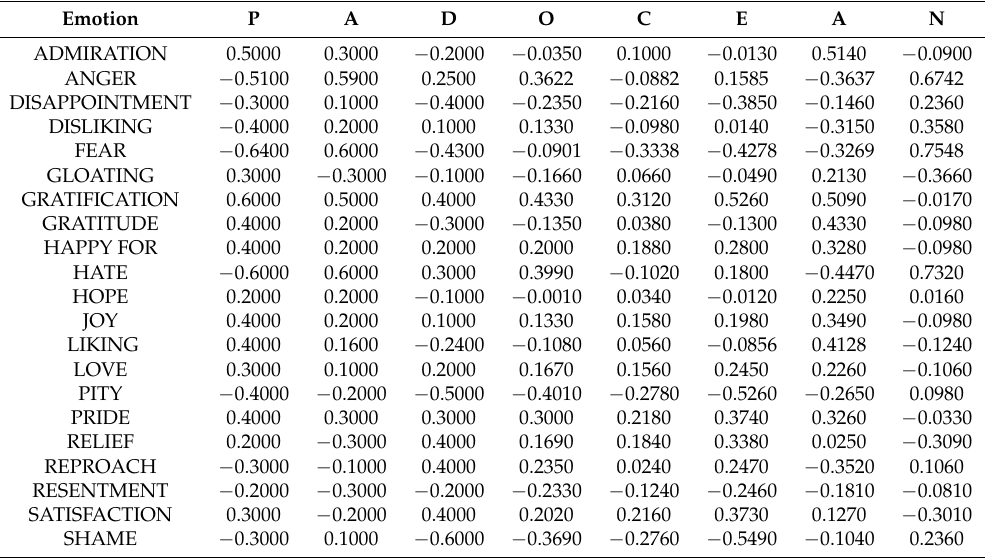
Table 1. The emotions Distress and Remorse weren’t used due to having Pleasure, Arousal, and Dominance (PAD) values are equal to Pity and Shame, respectively. PAD values from [17] and OCEANs values from [14].